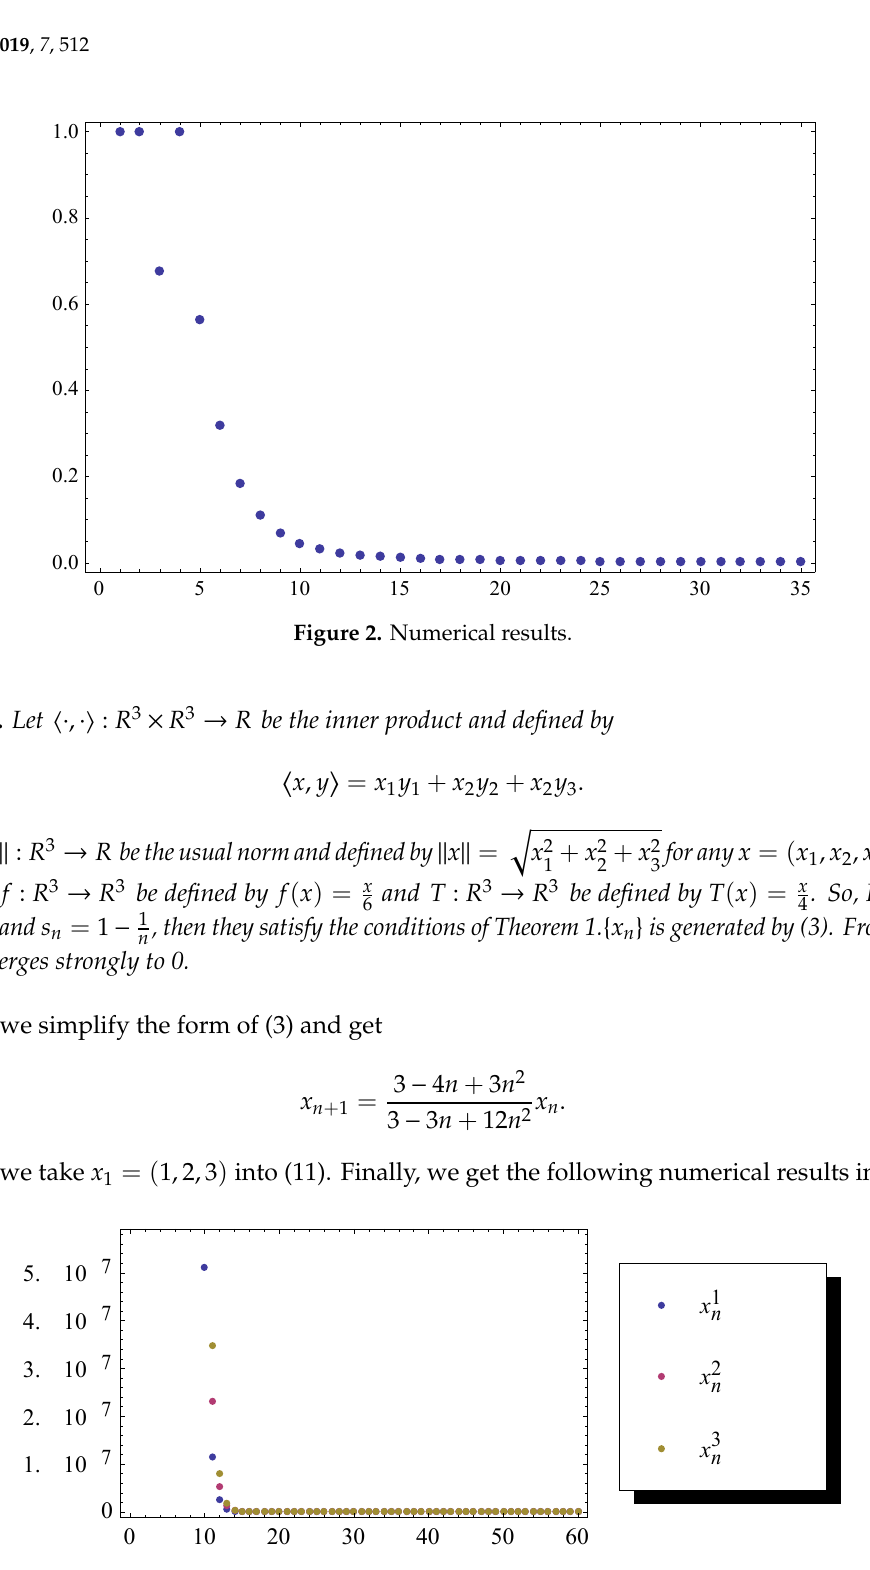
Figure 3. Numerical results.